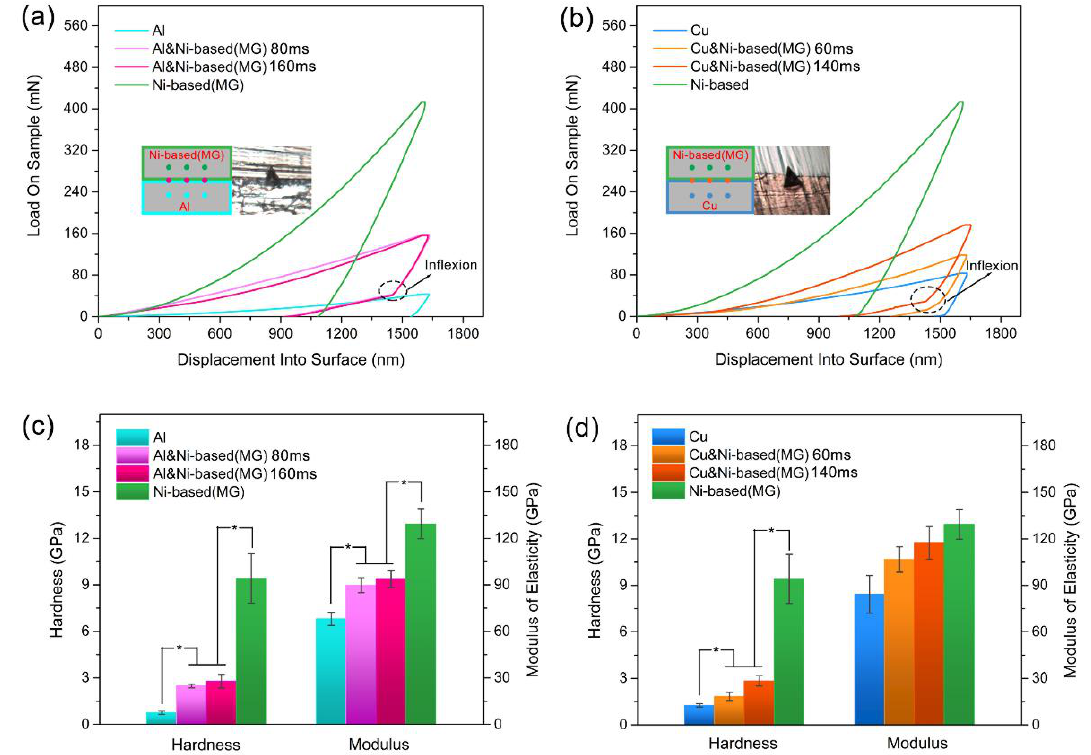
Figure 6. Nanoindentation curves ( a ) and the hardness and modulus ( c ) of the cross section of Al / Ni-based (MG) composite specimens at bonding times of 80 and 160 ms. Nanoindentation curves ( b ) and the hardness and modulus ( d ) of the cross section of the Cu / Ni-based (MG) composite samples at bonding times of 60 and 140 ms. Data presented as mean ± standard deviation, * p < 0.05. Table 3. The deformation relative to yielding (H / E) and resistance to the plastic indentation (H 3 / E 2 ).